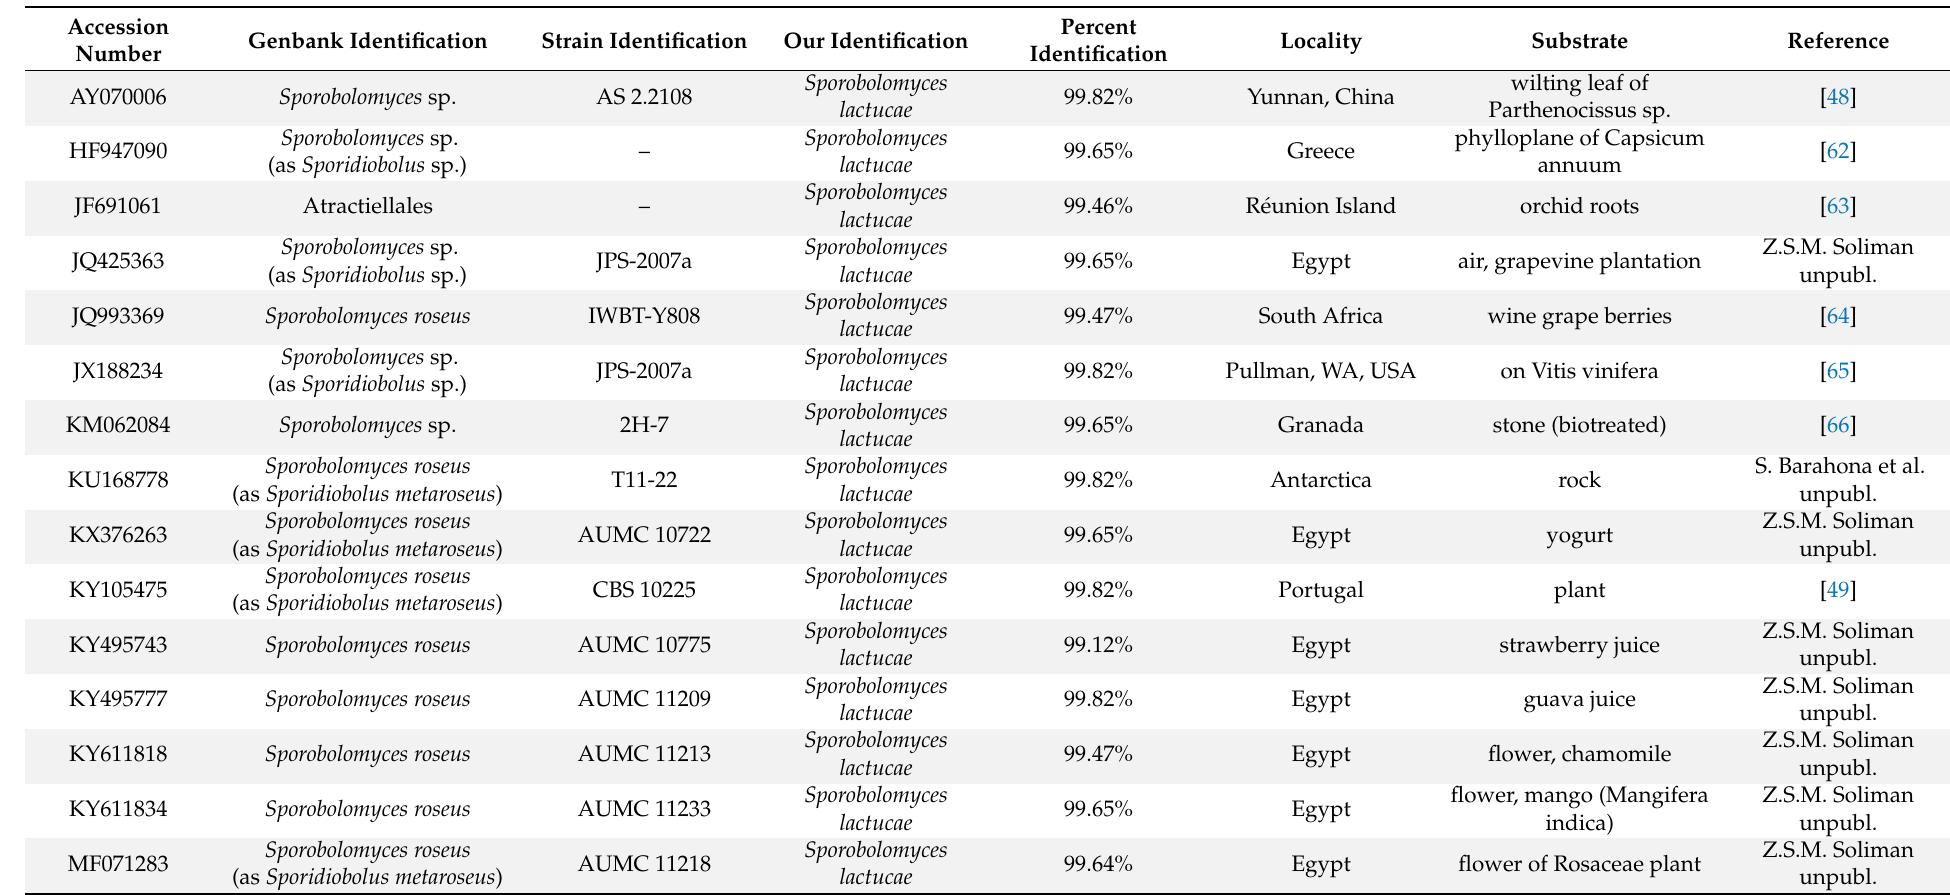
Table 3. Environmental sequences of S. lactucae included in ecological determination. ITS sequences were aligned and trimmed; a phylogenetic reconstruction of the ITS sequences was